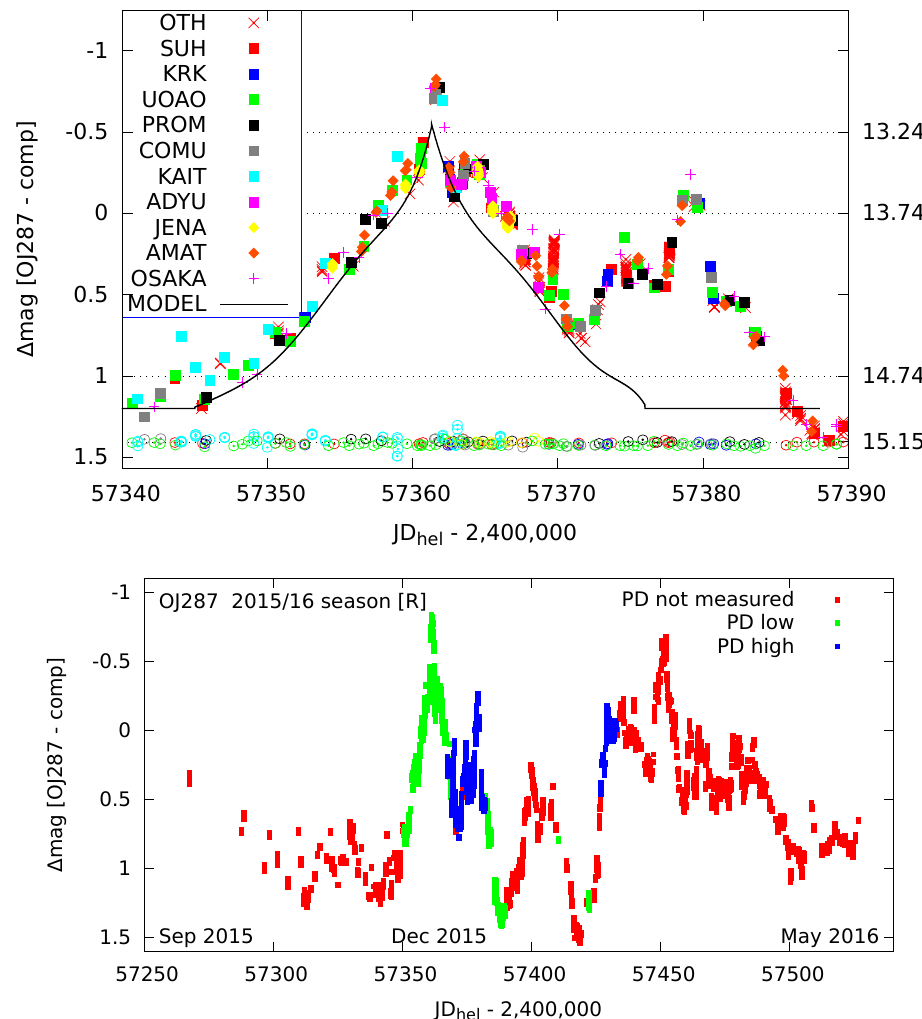
Figure 1. R -band light curve of OJ287 gathered during the 2015/2016 season. The December 2015 outburst is shown in the top panel, while the full-season light curve is in the bottom panel. The December 2015 high-amplitude flare turned out to be